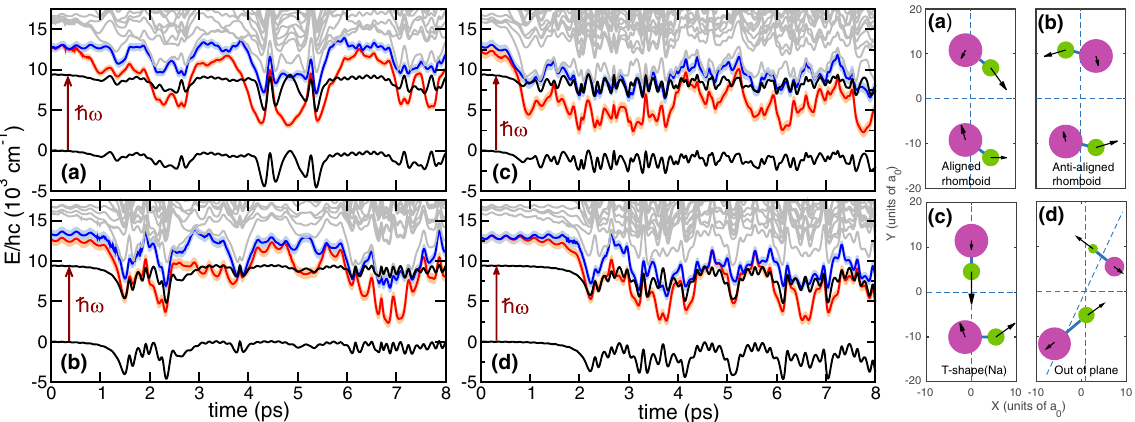
Figure 5. On-the-fly dressed-state model of optical excitations of two classically-colliding cold ground-state 23 Na 87 Rb molecules in the presence of an infra-red trapping laser with a wavelength of 1064 nm. Panels (a)-(d) show singlet ground- (solid black curve) and excited-states (solid red, blue, and grey curves) potential energies as functions of time during the first few ps of trajectories with zero impact parameter, but different initial relative orientations and velocities of the cold molecules. These initial orientations and velocities are shown in the four small panels on the right with corresponding panel labels. Large magenta and smaller green filled circles give the positions of Rb and Na atoms, respectively, while arrows of different lengths specify their velocities. The second higher-in-energy black curves in the panels on the left correspond to the ground-state potential plus the energy of a photon from the 1064 nm laser. Excitations occur when this dressed ground-state potential crosses that of excited states. The error bands on the potentials of the first (orange curve) and second (blue curve) excited states indicate the difference in energy splittings between excited states and the ground state as found by TD-DFT and EOM-CCSD calculations. Figures were prepared using Grace-5.1.22